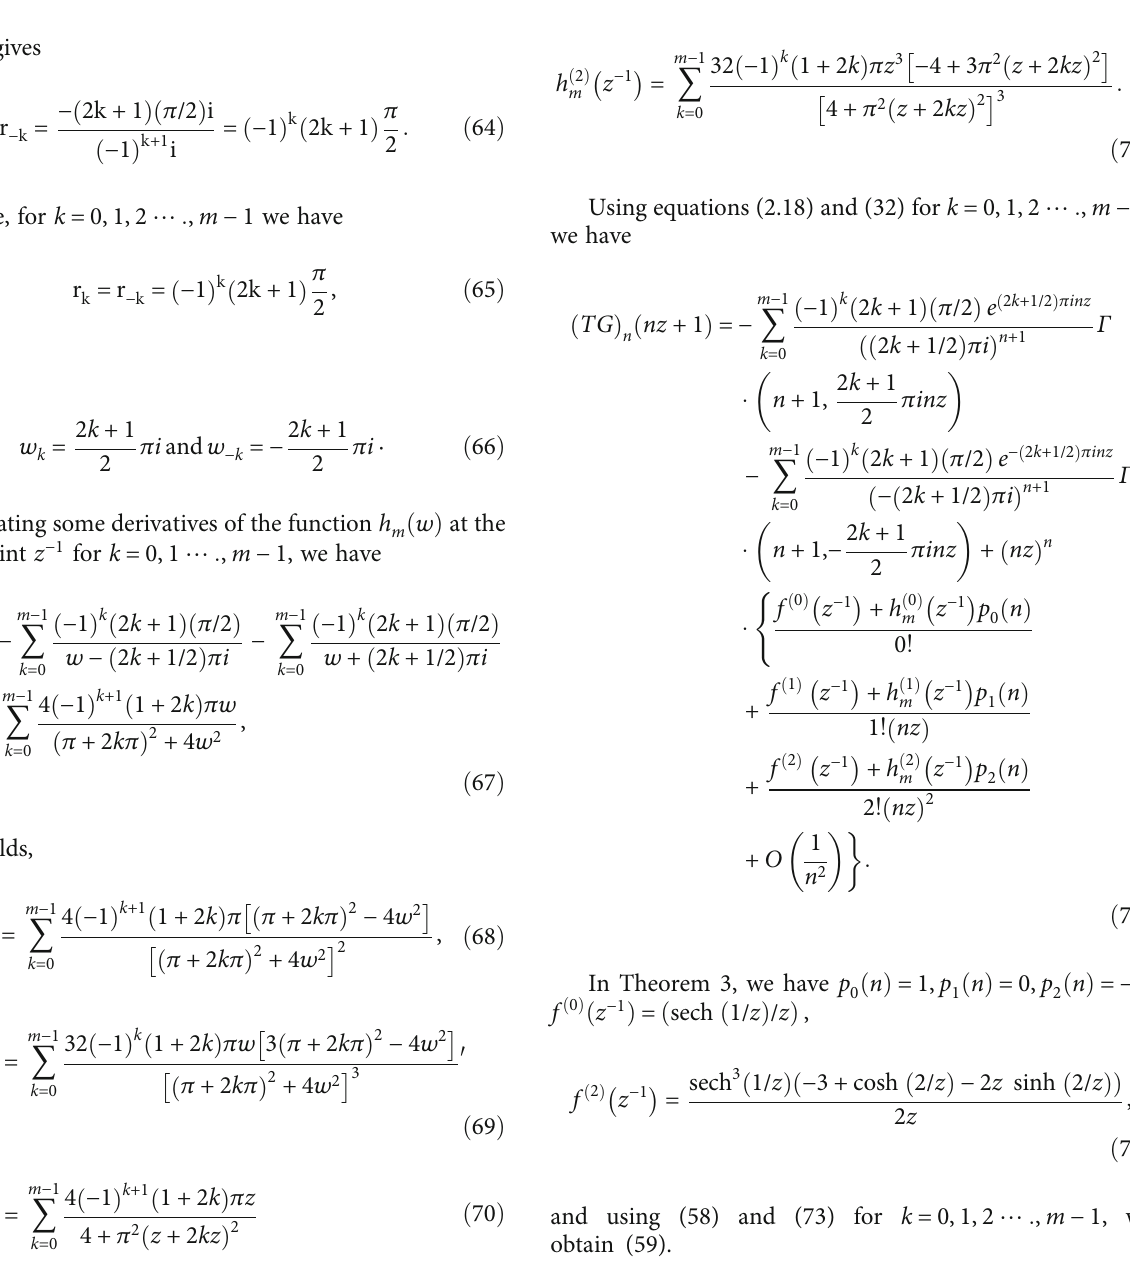
Figure 6: Solid lines represent ð TG Þ both normalized by the factor ð 1 + j x / α j n Þ